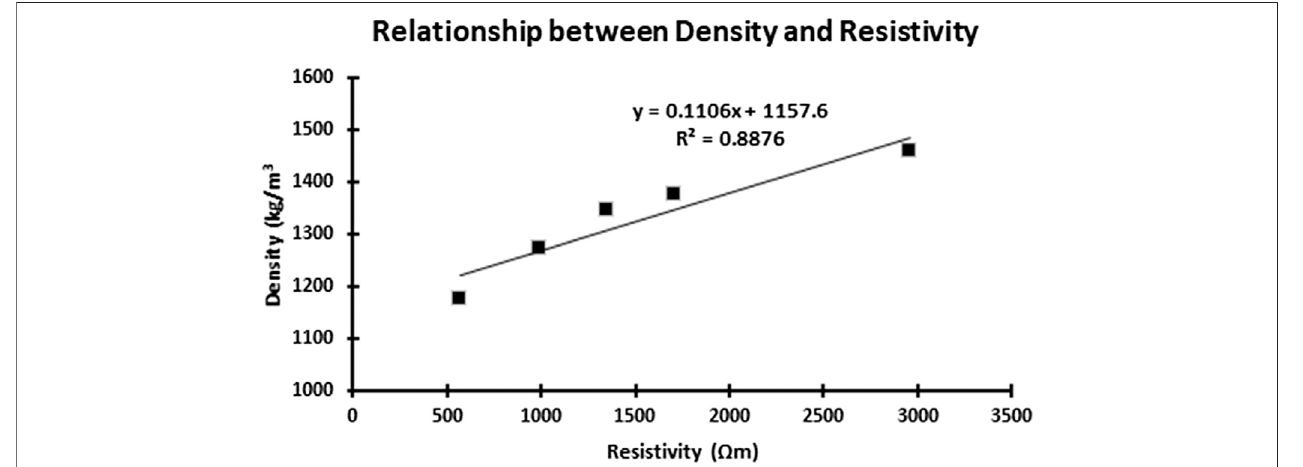
FIGURE 8 | Relationship between density and resistivity in the study location.